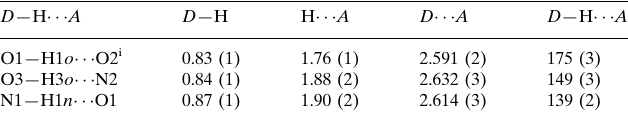
Hydrogen-bond geometry (A˚ , (cid:1)